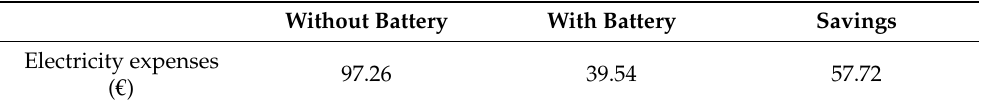
Table 5. Comparative of the electricity bills in the study period in the selected zone of the building considering or not the installation of the battery. Without Battery With Battery